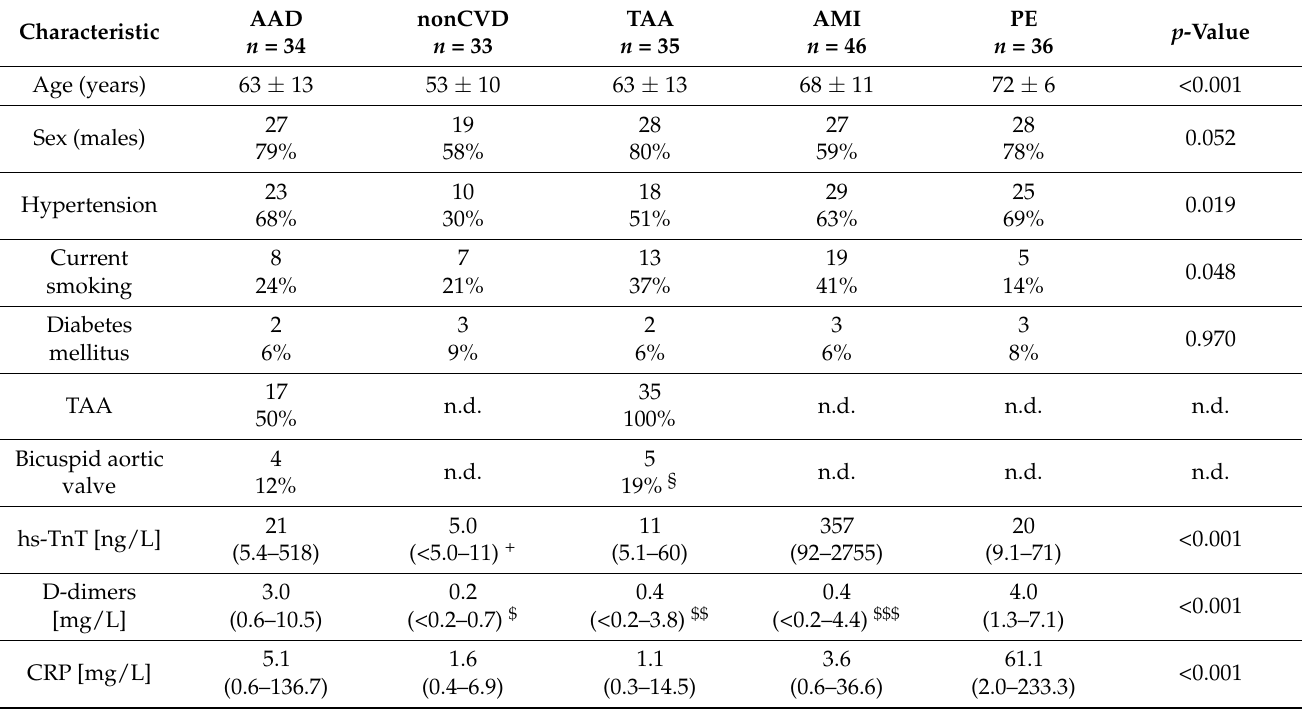
Table 2. Patients’ characteristics in the confirmatory